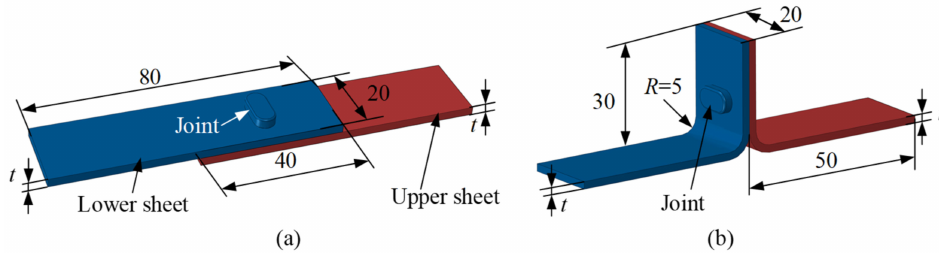
Figure 4. The structural dimensions of ( a ) single-lap and ( b ) T-lap samples (all dimensions in